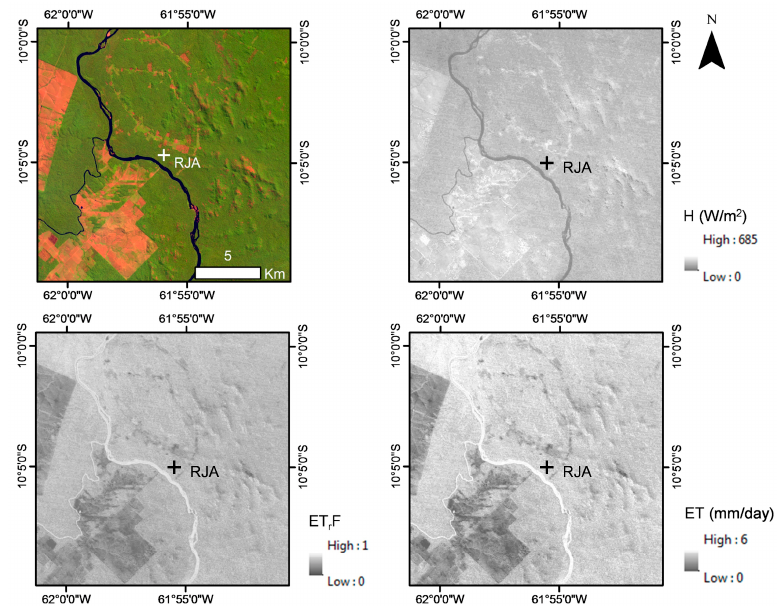
Figure 5. Illustration of METRIC derived products. Landsat image in RGB with bands 5, 4 and 3 ( upper left ), Sensible Heat ( upper right ), ET r F ( lower left ) and METRIC ET ( lower right ) over the RJA site in Rondônia. Image date: 13 July 2002.